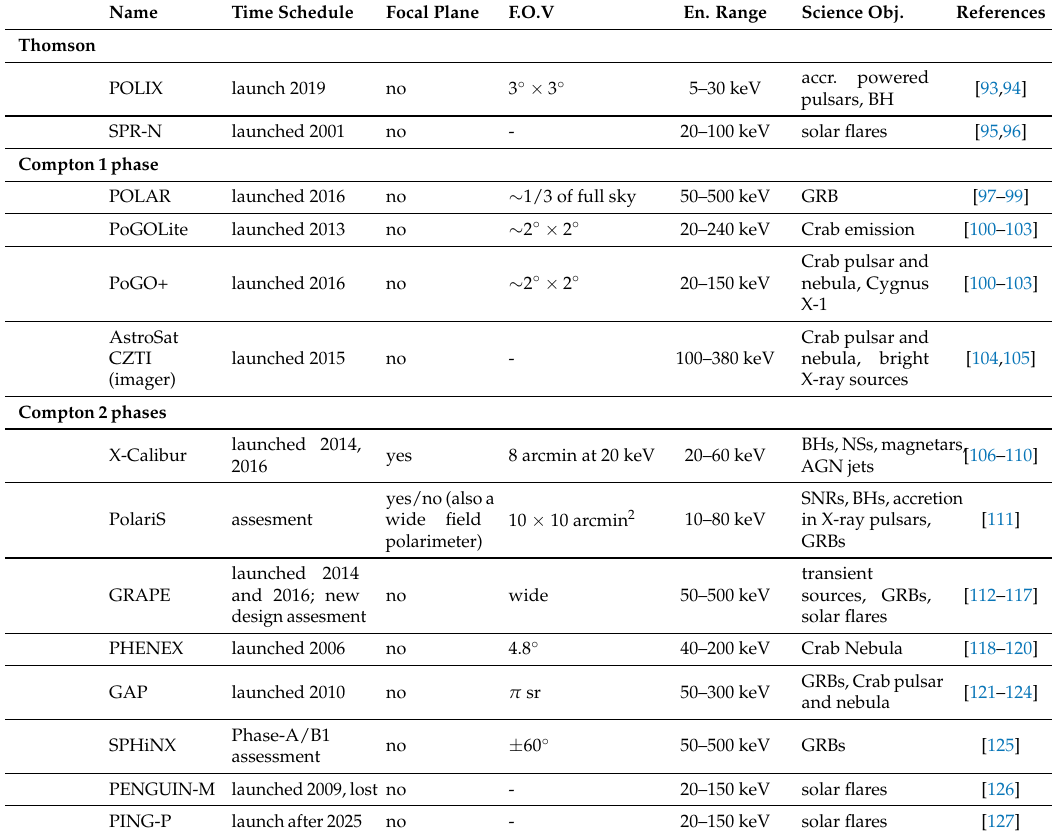
Table 4. Relevant scattering polarimeters